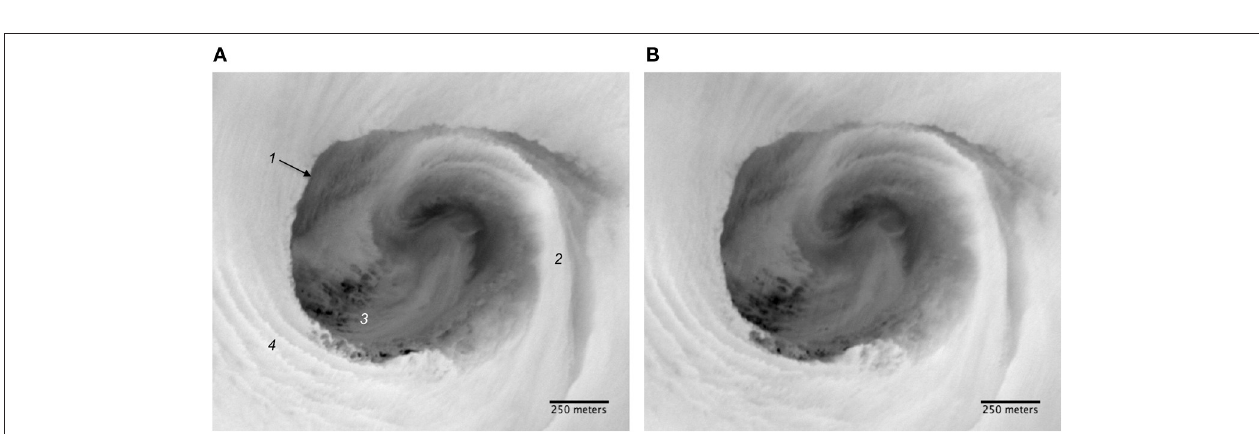
FIGURE 1 | Infrared imagery showing two possible stages in the evolution of a cyclonic eddy downstream of Catalina Island (inset). (A) Early stage, eddy spinning-up directly downstream from the west end of the island. Isolated signature in the west is a boat wake. Data from 2 February 2013, 1824 UTC. (B) Later stage, showing cold eddy fully encapsulated by warmer water. Brighter areas along the southern edge of the image strip are sun-glint contamination. Data from 1 February 2013, 2026 UTC.